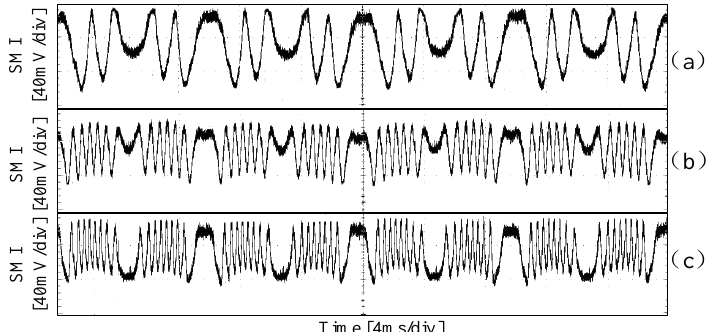
Figure 6. SMI signals for VPZT with frequency of 100 Hz but different amplitudes. ( a ) V PZT = 3.6 V, ( b ) V PZT = 8.0 V, ( c ) V PZT = 11.0 V.